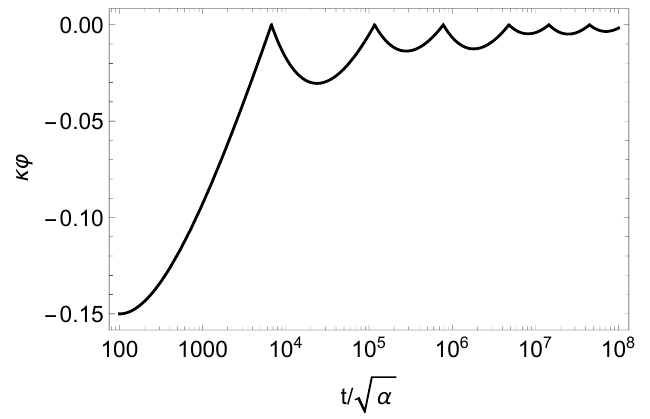
Figure 7 . The evolution of scalaron in the large (cid:28) limit for (cid:24) = 0 : 1 corresponding to the solution of eq. (4.3). The boundary condition (cid:30) ( (cid:28) = 10 2 ) = (cid:0) 0 : 15 and _ (cid:30) ( (cid:28) = 10 2 ) = 0 are chosen from (cid:12)gure